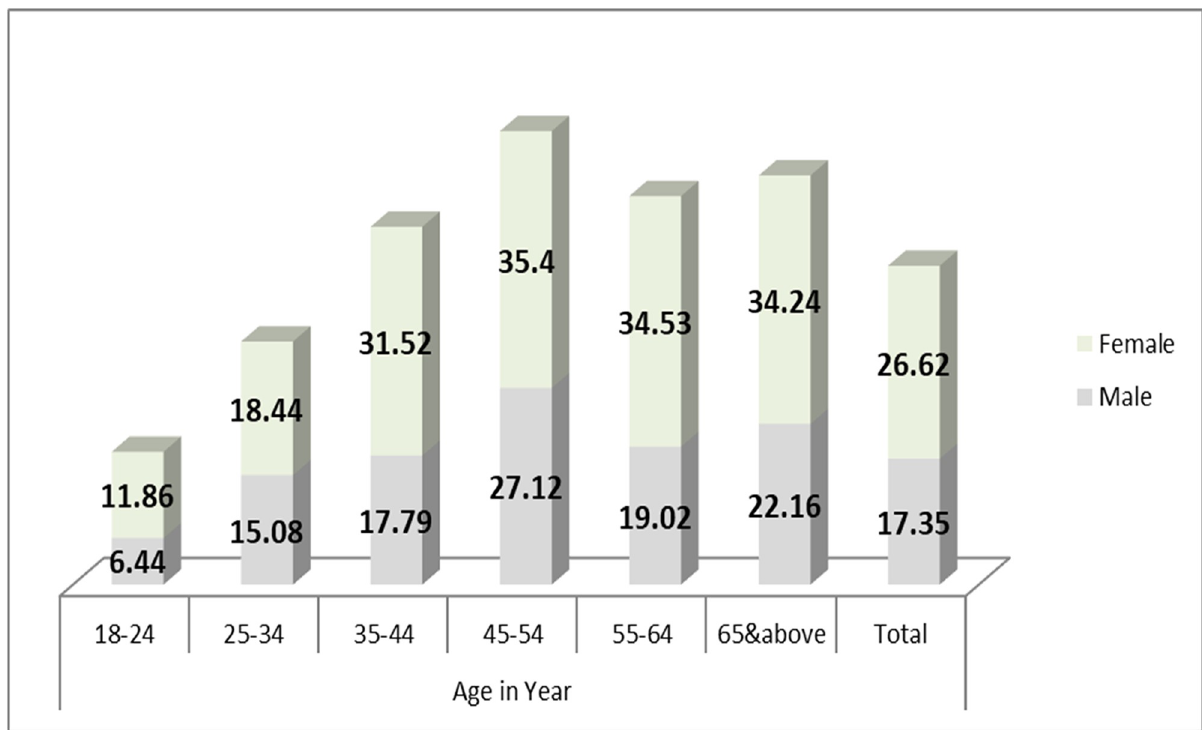
Fig 2. Distribution of high total cholesterol level by age and sex among � 18years old Gondar city residents, Northwest Ethiopia.